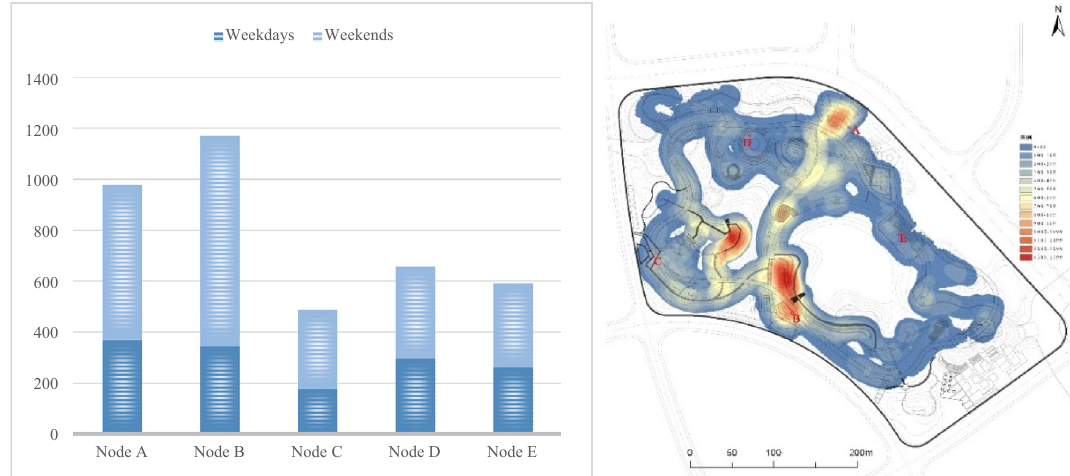
Figure 2. Schematic diagram of the flow of people in different times and